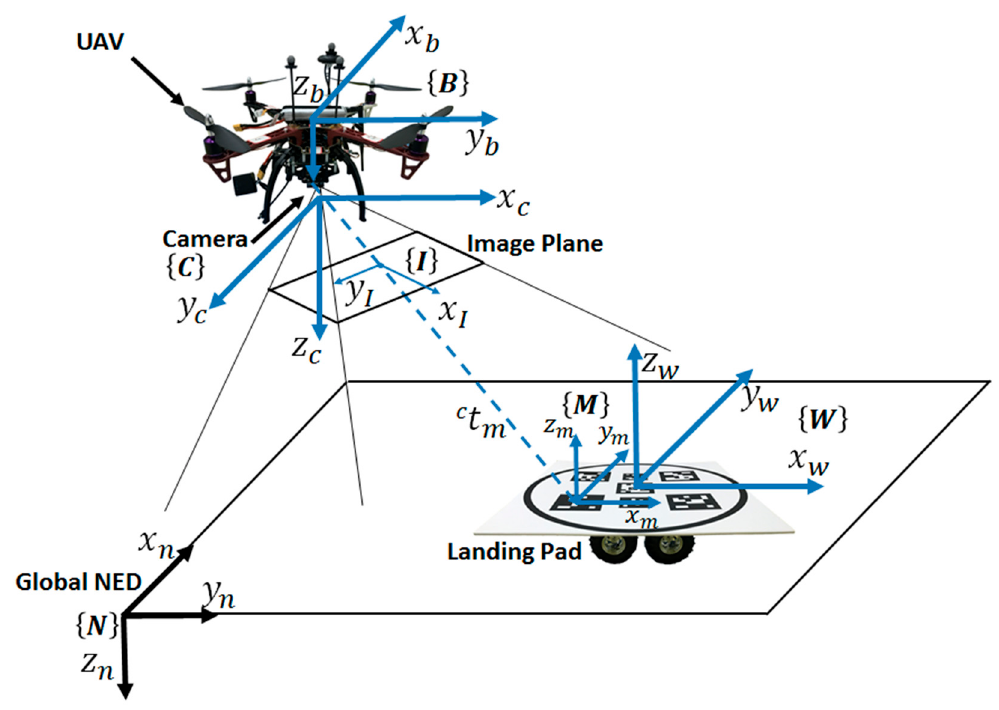
Figure 3. Definition of the unmanned aerial vehicle (UAV) body frame B , the camera frame C , the image frame I , the marker frame M , the world frame W , and a North–East–Down (NED) coordinate system taken as an inertial reference frame N .